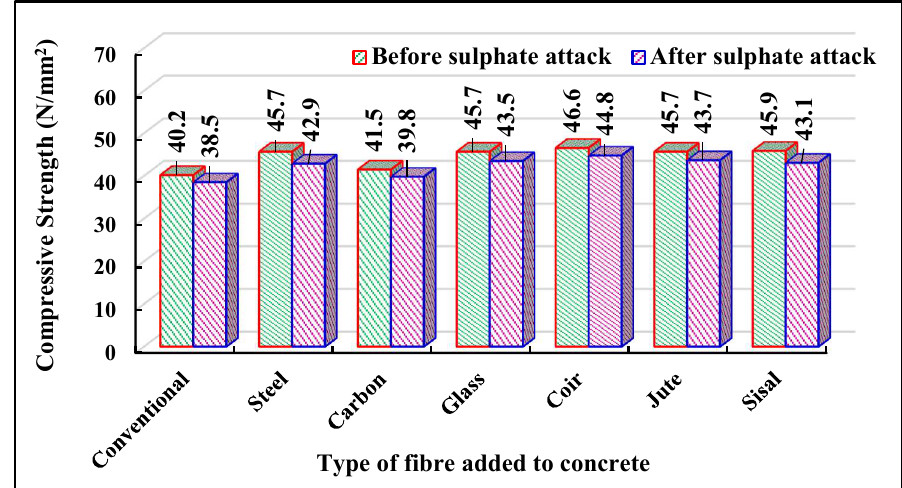
Figure 14. Graphical illustration of compressive strength of FRC due to sulphate attack.